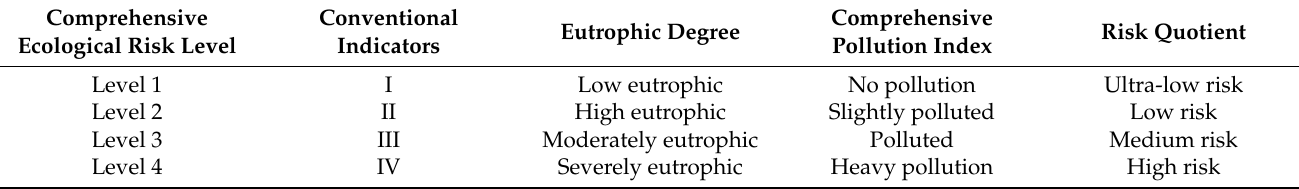
Table 6. Comprehensive ecological risk